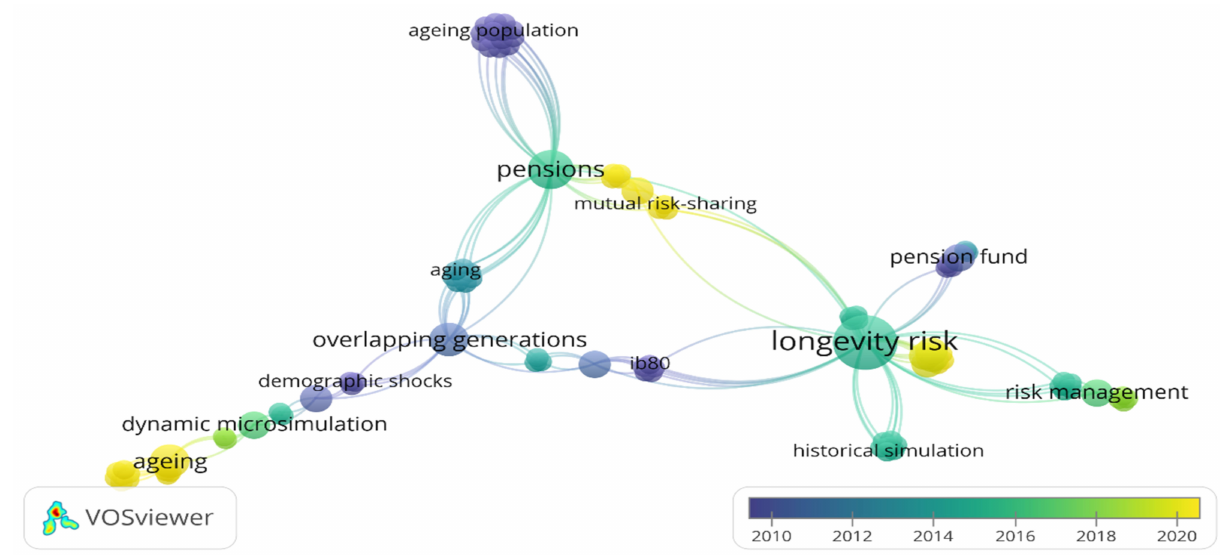
Figure 14. Evolution of main keywords network based on co-occurrence in the Mathematics area (1999–2021). Source: own